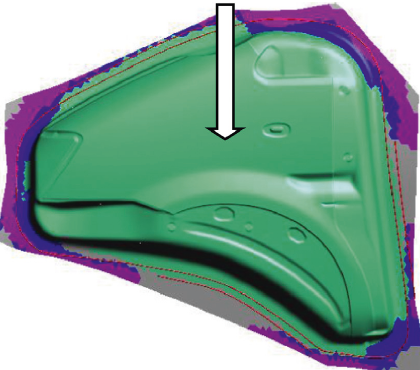
Figure 1: Fender model and stamping direction.